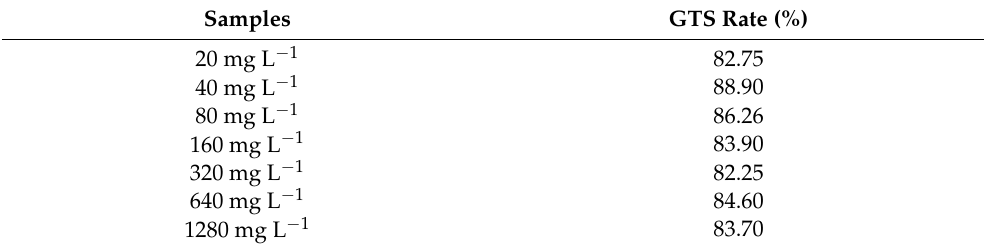
Table 3. Percentage changes of the genomic template stability (GTS %) found in roots of safflower 21